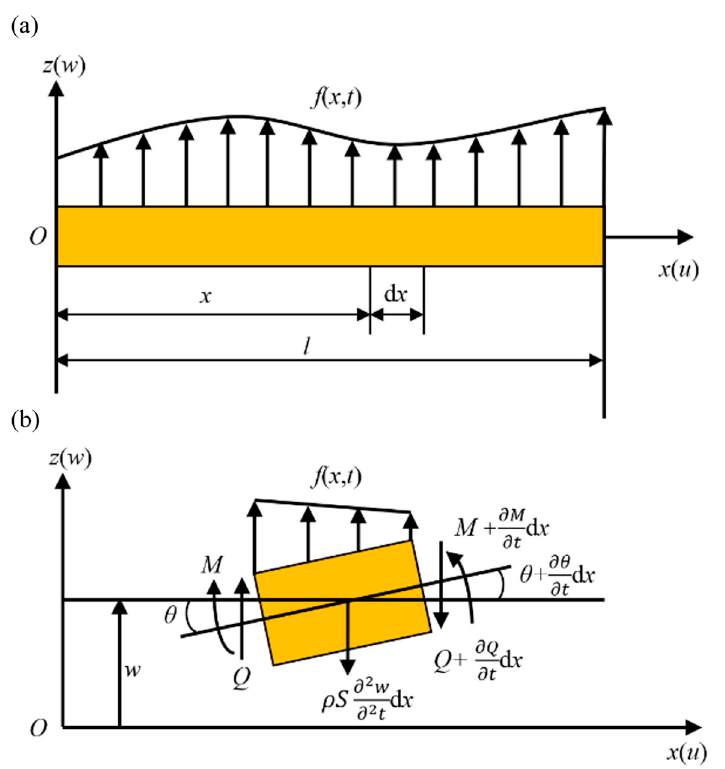
Figure 3. Diagram of force analysis of cantilever beam. ( a ) Force analysis of beam transverse vibration. ( b ) Force analysis of a micro-element on the transverse vibrating beam.